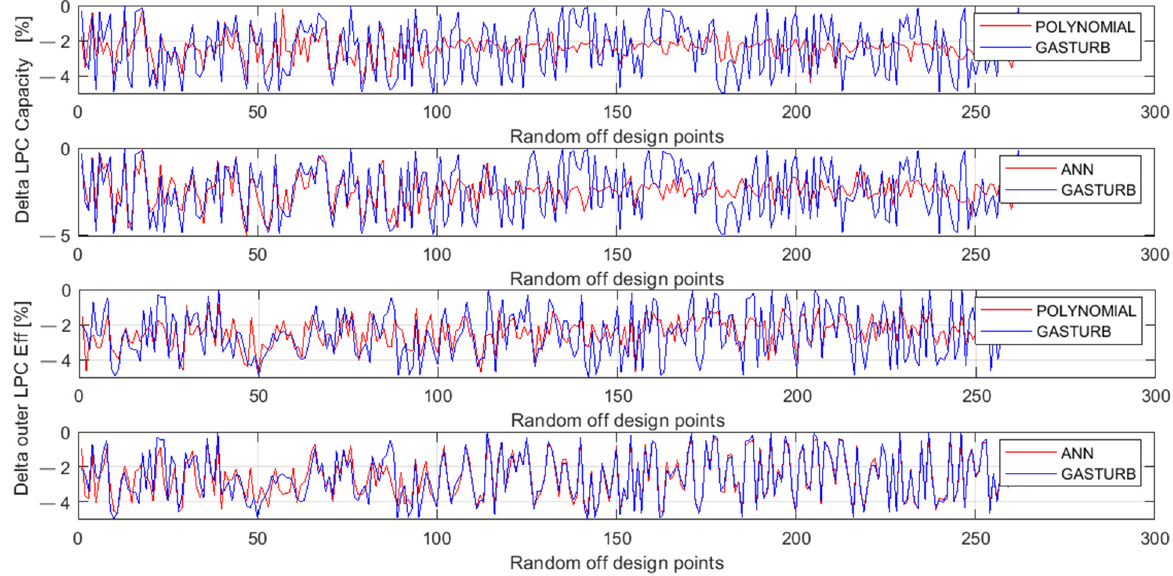
Figure 7. Ventilator fault parameters generated by GasTurb and approximated by the polynomials and MLP. Figure 8 helps to analyze the behavior of the rest of the fault parameters. A general impression of the plots presented here is that the simulated values satisfactorily follow original ones. All errors are significantly lower than those of the ventilator